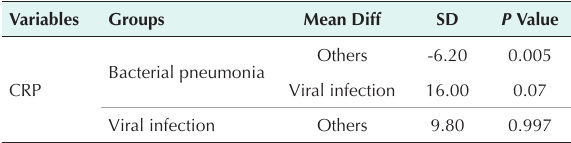
Table 3. The Results of Scheffe Post Hoc